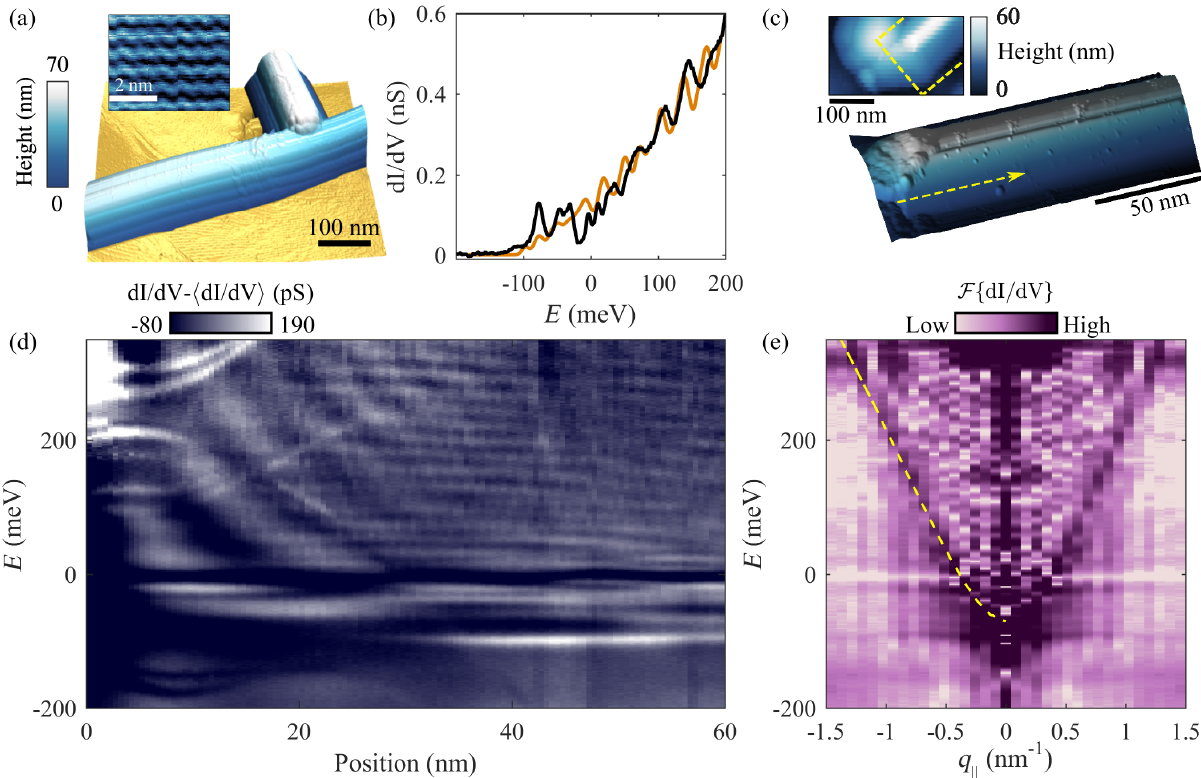
FIG. 1. Visualizing 1D subbands in semiconducting InAs nanowires. (a) STM topography of two InAs nanowires intersecting on top of the Au surface. Inset: Resolved atomic structure of the f 11 – 20 g facet expected of a Wurtzite nanowire grown in the h 0001 i direction. (b) dI/dV measurement (black) and ab initio calculation (orange), both showing the semiconducting gap and onset of the quantized conduction band in the form of van Hove singularities in the LDOS. (c) Topographic image showing a clean facet at a nanowire end. Inset: Topographic image of the catalyst Au droplet terminating the nanowire. The clean facet location is marked by the dashed frame. (d) dI/dV measurement along a line cut on the clean facet [dashed arrow in (c)] showing a dominant dispersing QPI pattern above the semiconducting gap alongside nondispersing van Hove peaks. A mean spectrum, h dI = dV i , taken far from the nanowire end [similar to (b)] was subtracted. The residual strength of dI/dV modulations is at most 30% of that mean value. (e) Fourier transform of (d) showing a dominant mode associated with the lowest subband of the quantized conduction band in full agreement with ab initio calculations (dotted line). Faint dispersing QPI of higher subbands are observed as